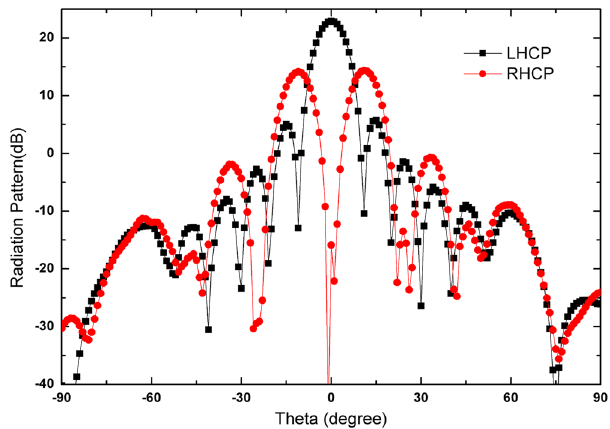
Figure 10. Radiation patterns of the Hertzian dipole array on a grounded slab for the LHCP